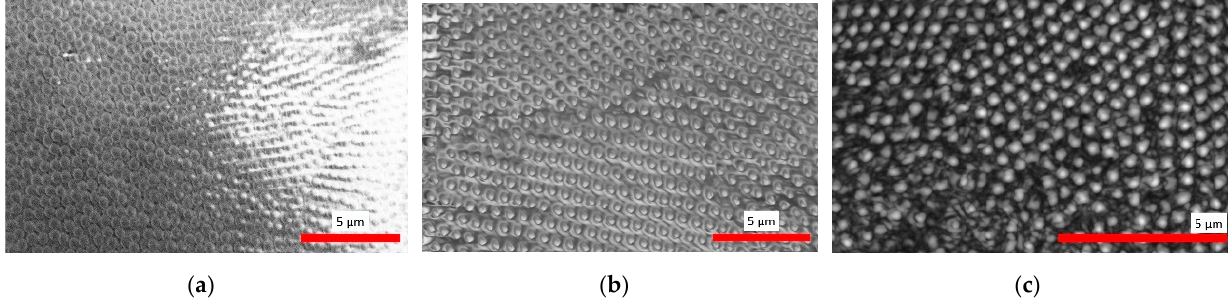
Figure 3. SEM images of the PS sphere coated pine wood sample before ( a ) and after O 2 plasma treatment ( b ), as well as a CLSM image after the O 2 plasma treatment ( c ) with a magnification of 12000 × .